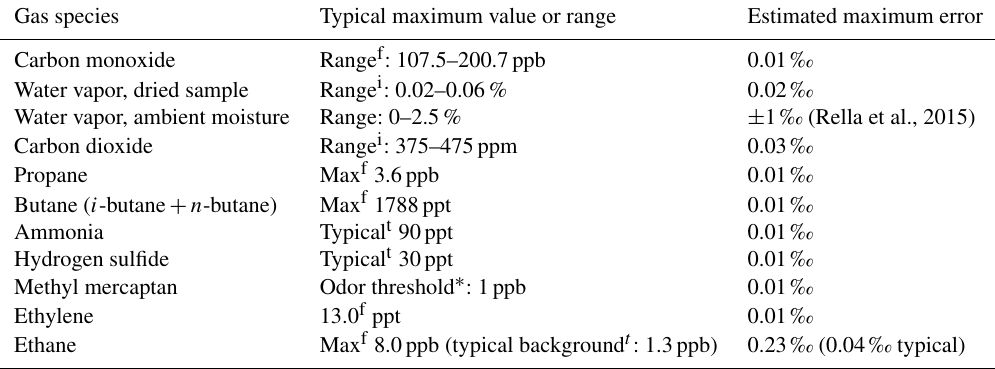
Table 2. Maximum error estimate attributable to cross-interference due to direct absorption on δ 13 CH 4 . These estimates were based on typical values for this tower-based application and estimated effects on CRDS measurements (Rella et al., 2015), and assumed 2ppm ambient CH 4 mole fraction. For water vapor and carbon dioxide, the interferences are independent of CH 4 mole fraction for 1–15ppm. For the other species listed, the interferences are inversely proportional to CH 4 mole fraction. Typical maximum values determined by flask f (level at which 99% of (afternoon) flask measurements at the south and east towers are below), by in situ measurements at Marcellus towers i , or by typical values t (Warneck and Williams, 2012).